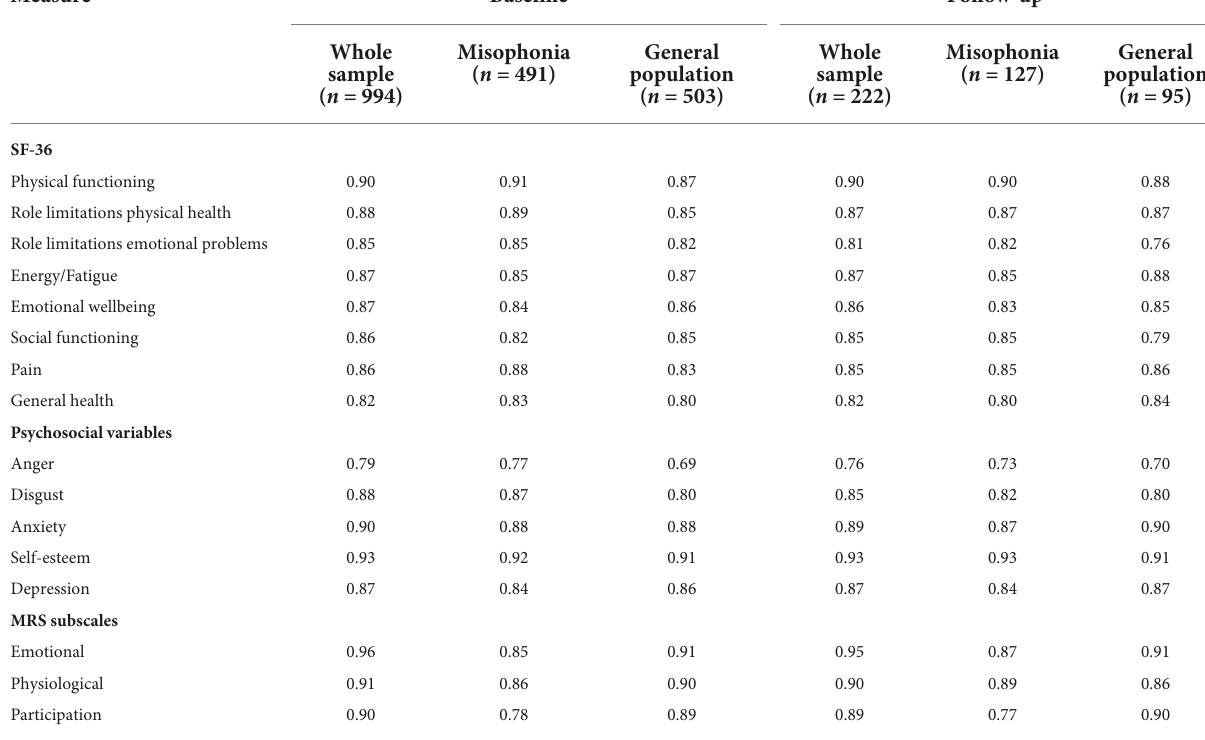
TABLE 1 Cronbach’s alpha for whole sample and by group at baseline and follow-up.